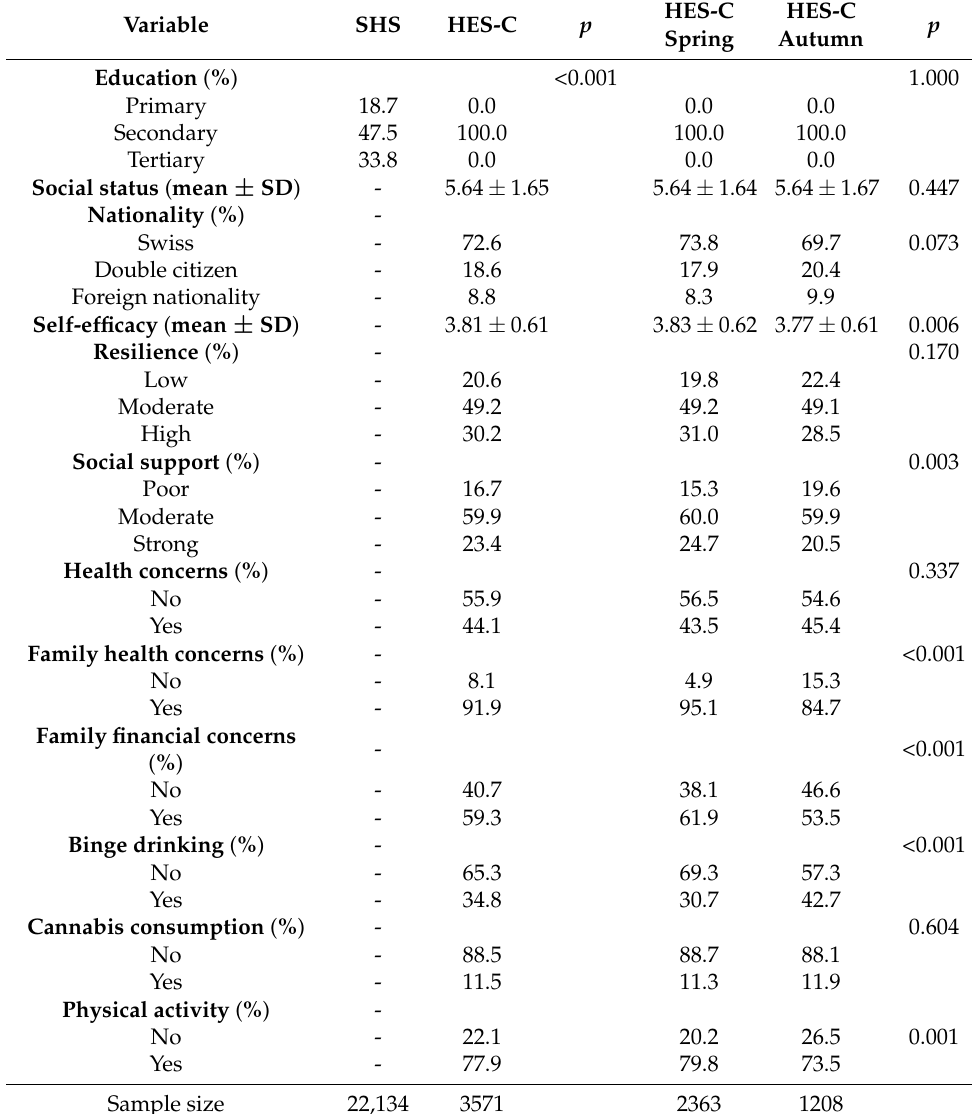
1 Percentages based on population-weighted data. Two-week prevalence for depressive symptoms and depression severity. p -values for comparison between SHS and HES-C from design-based F-test. Sources: Swiss